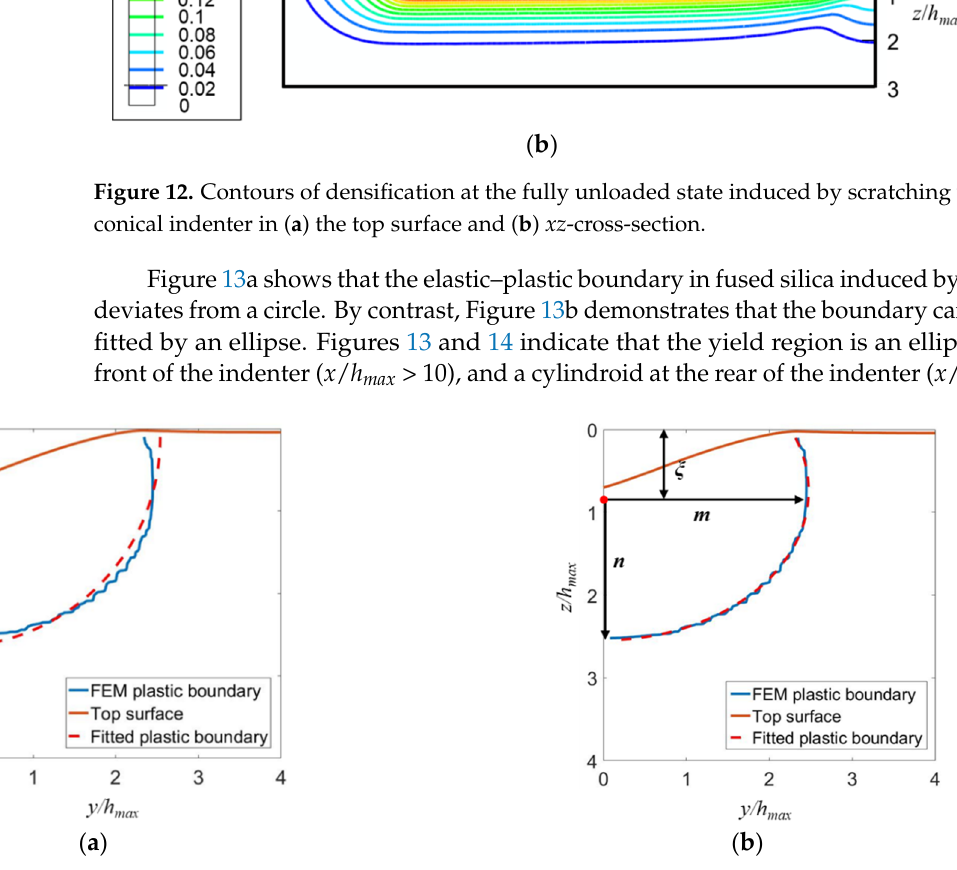
Figure 13. The elastic–plastic boundaries defined by a von Mises equivalent plastic strain of 10 −2 in the yz -cross-section at the fully unloaded state for 70.3° conical scratching. The simulated boundaries are fitted by ( a ) a circular arc and ( b ) an elliptical arc.